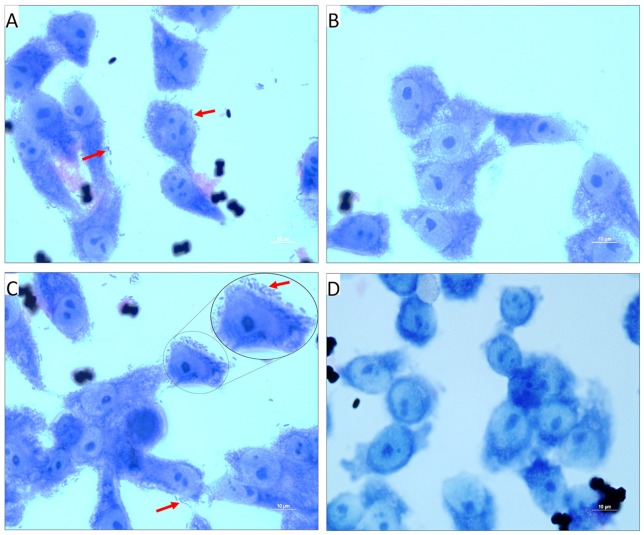
Light micrographs showing the adhered V. cholerae onto INT 407 monolayer cells. (A,C) Control panels of INT 407 cell lines infected with MTCC3905 reference strain and clinical isolate, Vc4, respectively. The red arrow mark represents the adhered bacterial cells onto the intestinal cell lines producing a carpet like aggregate pattern. (B,D) PDCApy treated MTCC3905 reference strain and clinical isolate, Vc4 bacterial cells adhered to INT 407 cells, respectively. PDCApy treated cells, showed a significant reduction in adherence to the cell lines as compared to the control. Scale bar in micrographs represents 10 μm.